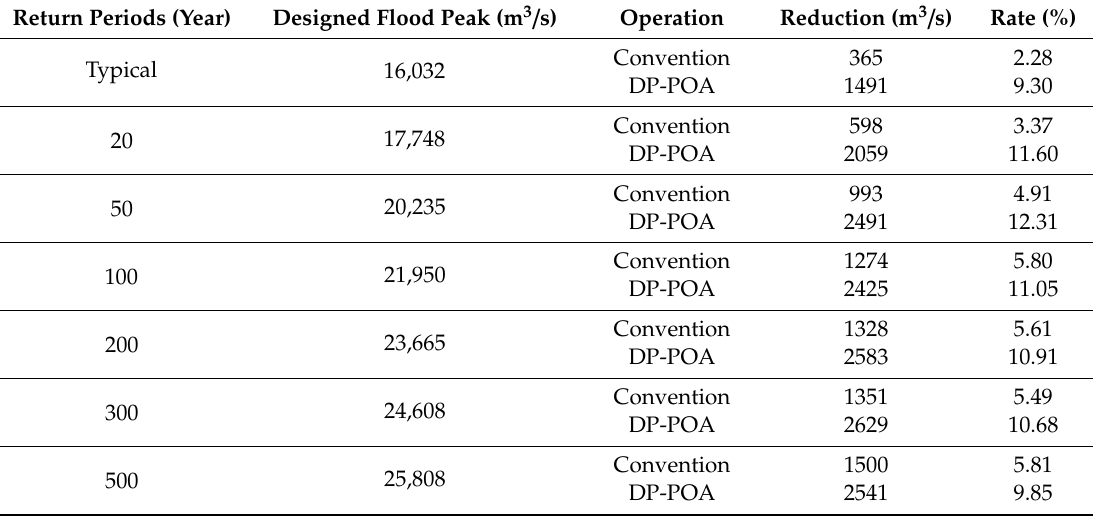
Table 7. Flood peak at the Ji’an flood control